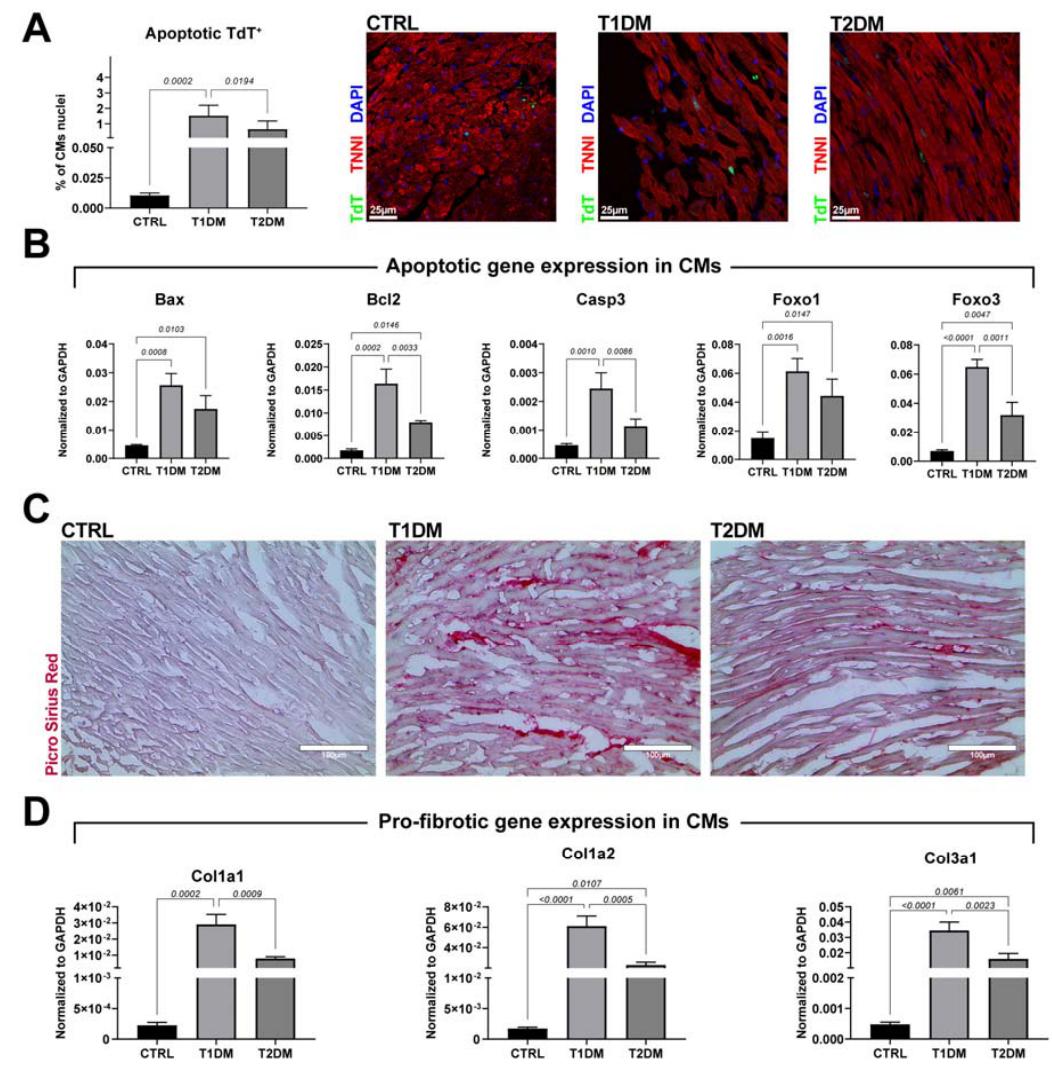
Figure 3. STZ-based T1DM and T2DM mouse models differed in accumulation of reactive interstitial fibrosis in the left ventricular myocardium. ( A ) Bar graph and representative confocal images of apoptotic TdT (green)-positive cardiomyocyte nuclei in T1DM and T2DM mice compared to CTRL mice. Scale bar = 25 µ m. (CTRL, n = 7; T1DM, n = 8; T2DM, n = 9.) ( B ) Bar graphs showing the expressions of apoptotic genes in cardiomyocytes isolated from CTRL, T1DM and T2DM mice (n = 3). ( C ) Representative light microscopy of Picrosirius red staining of T1DM and T2DM mice compared to CTRL mice. Scale bar = 100 µ m. (CTRL, n = 7; T1DM, n = 8; T2DM, n = 9.) ( D ) Bar graphs showing the expressions of profibrotic genes in cardiomyocytes isolated from CTRL, T1DM and T2DM mice (n = 3). Data are mean ±